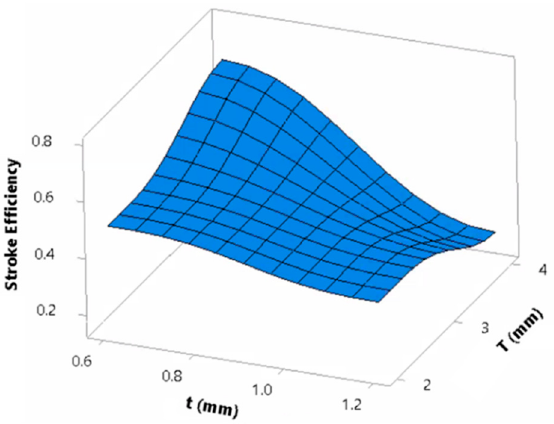
Figure 18. Dependence of (cid:2013) (cid:3046)(cid:3047)(cid:3045)(cid:3042)(cid:3038)(cid:3032) on the interaction of top-plate and tube thicknesses.